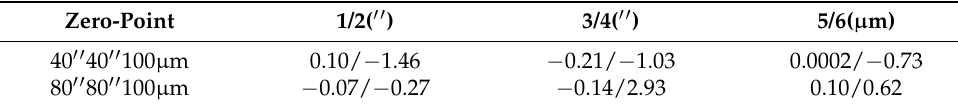
Table 2. Encoder average residual of the zero-point.